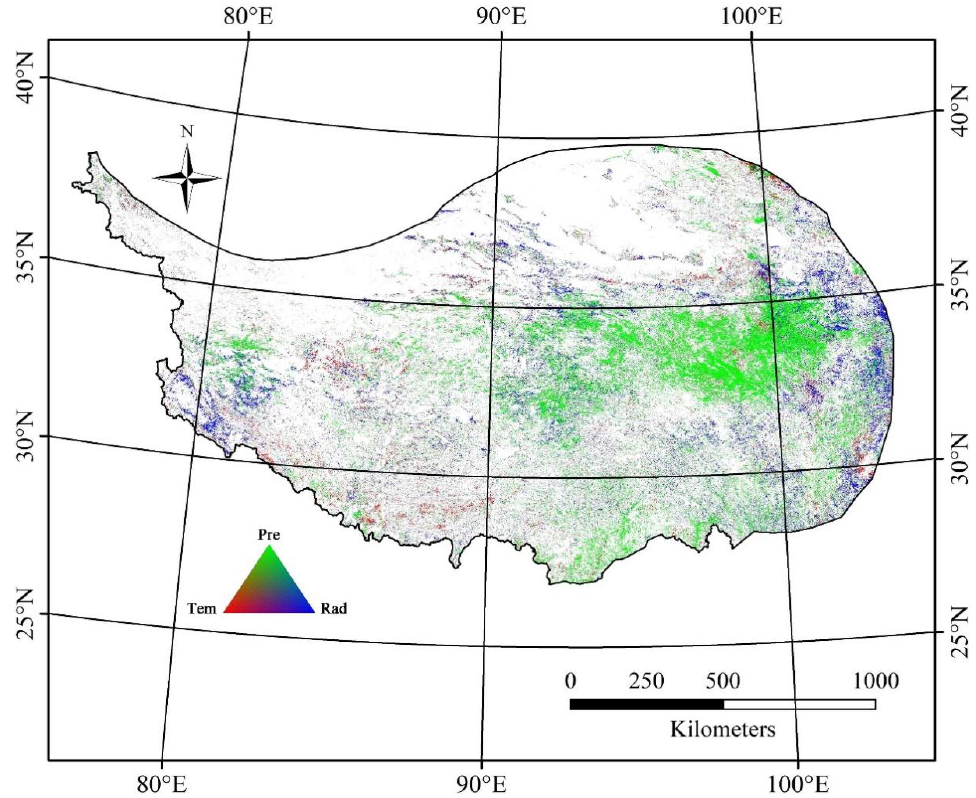
Figure 5. Relative impacts of climate factors on NPP. Tem, temperature; Pre, precipitation; Rad, solar radiation. Only pixels with significant ( p < 0.05) sensitivity are displayed.